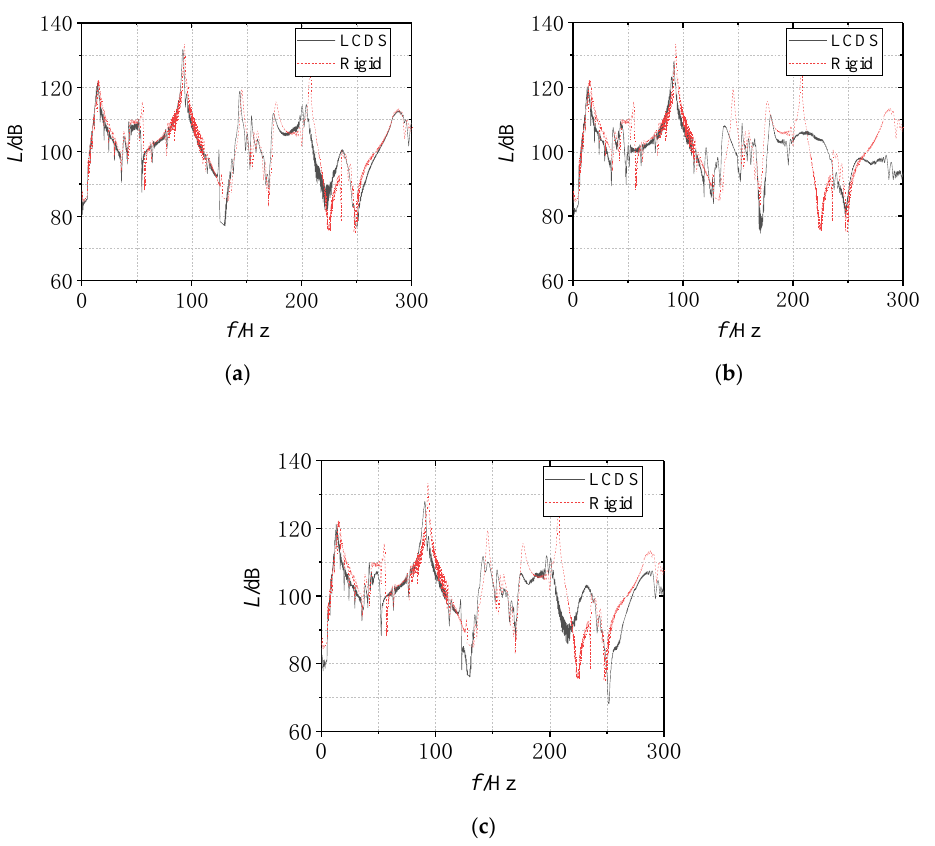
Figure 13. Vibration response curve of pipeline with different coated layers: ( a ) one coated layer; ( b ) two coated layers; ( c ) three coated layers.